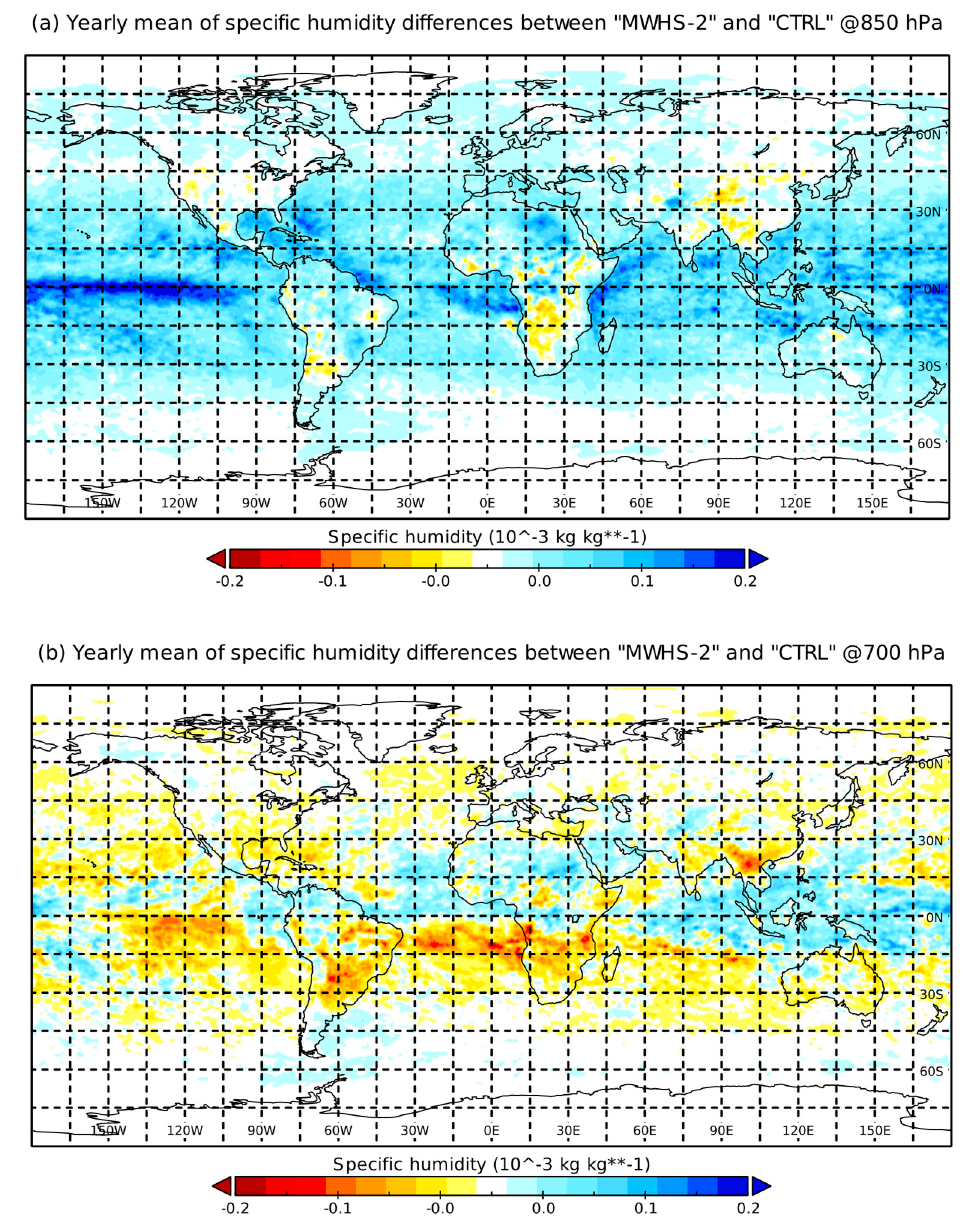
Figure 5. Geographical distribution of yearly mean specific humidity differences (g/kg) between the